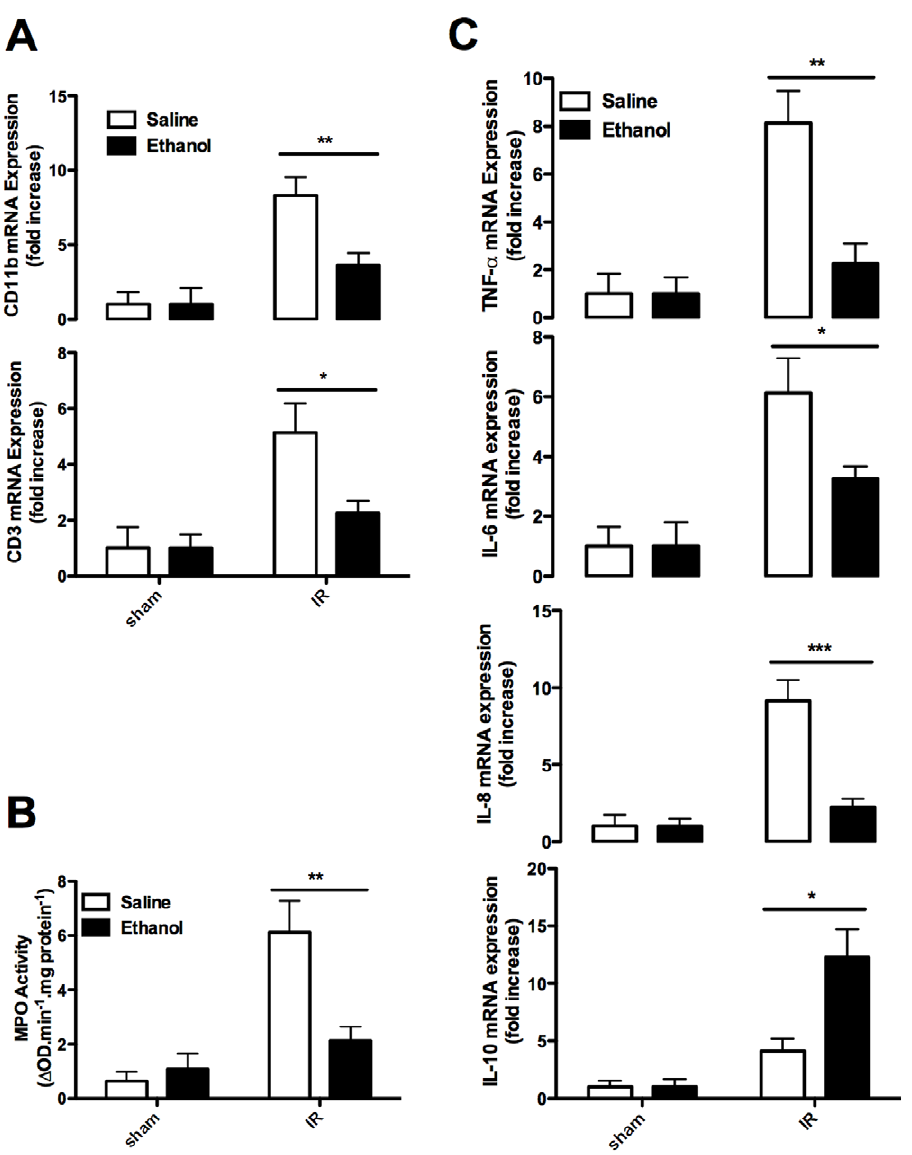
Figure 4. Ethanol pretreatment attenuated inflammation after renal IR. Mice were pretreated with saline or 1 g/kg ethanol, and were exposed to a 30-min bilateral renal IR 3 h later. Kidney samples were collected at 24 h post reperfusion and assessed for: A. CD11b, CD3 mRNA expression; B. MPO activity; and C. TNF- a , IL-6, IL-8 and IL-10 mRNA expression. Results are mean values 6 SEM. ( n =4–6). (* p , 0.05, ** p , 0.01, *** p ,